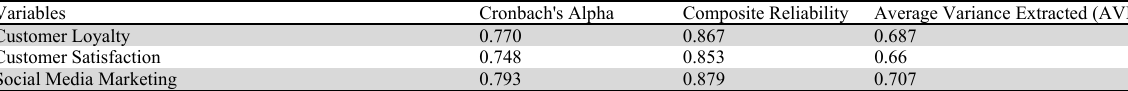
Average Variance Extracted (AVE)